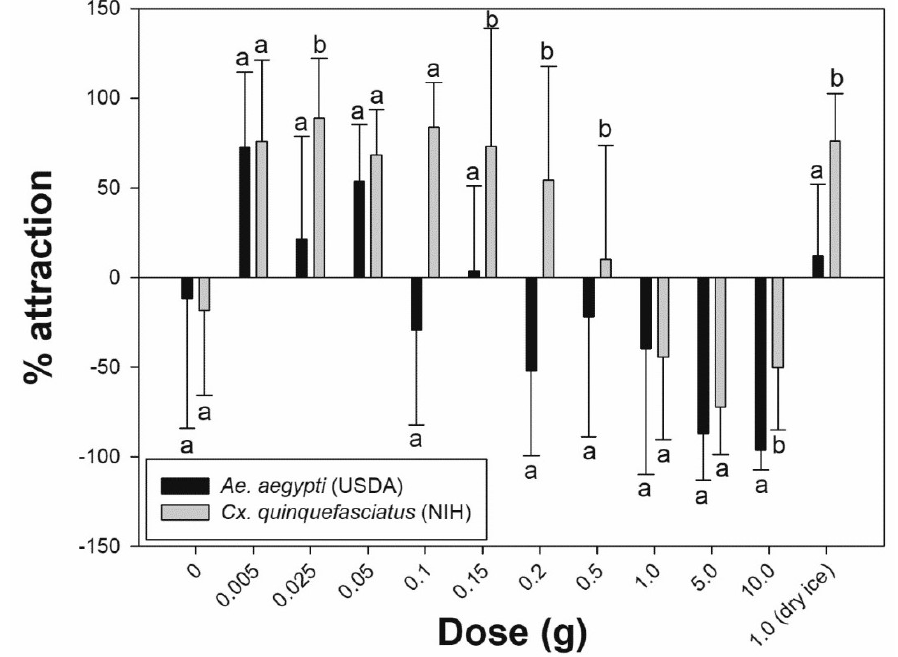
Figure 3. Percentage attraction between pyrethroid susceptible species, Aedes aegypti USDA and Culex quinquefasciatus NIH. Different letters between species indicate statistical significance (Mann–Whitney U test, p < 0.05).